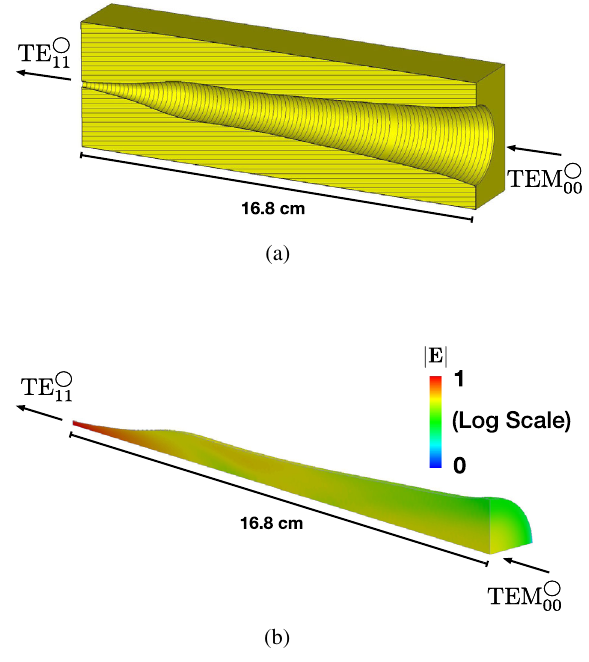
FIG. 15. Gaussian-to-TE ○ 11 mode converter, adapted from Toufexis et al. [23]. (a) Metallic surface and (b) Surface electric field profile (log